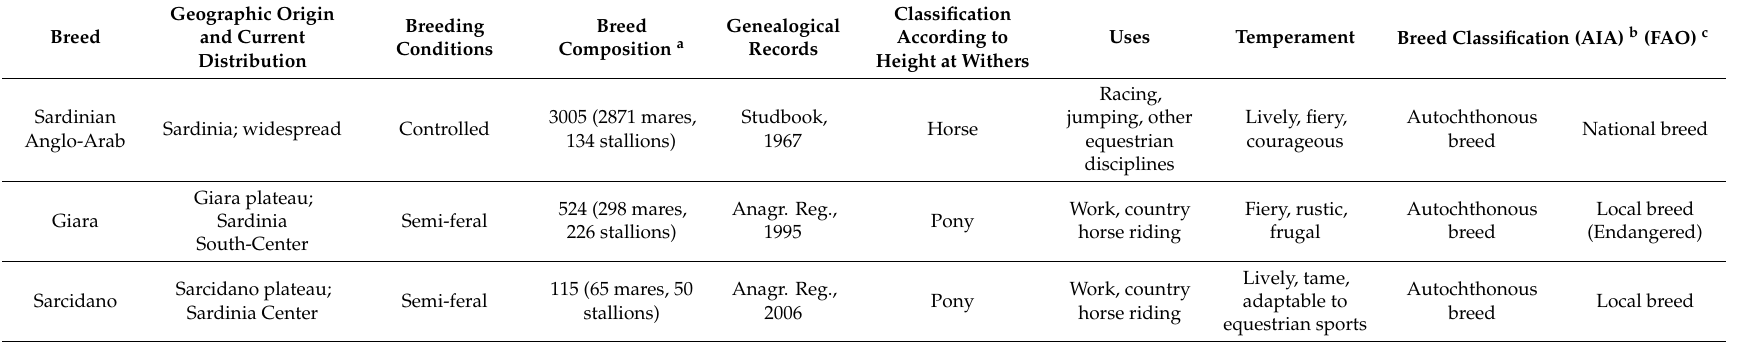
Table 1. List and current breeding context of Sardinian horse